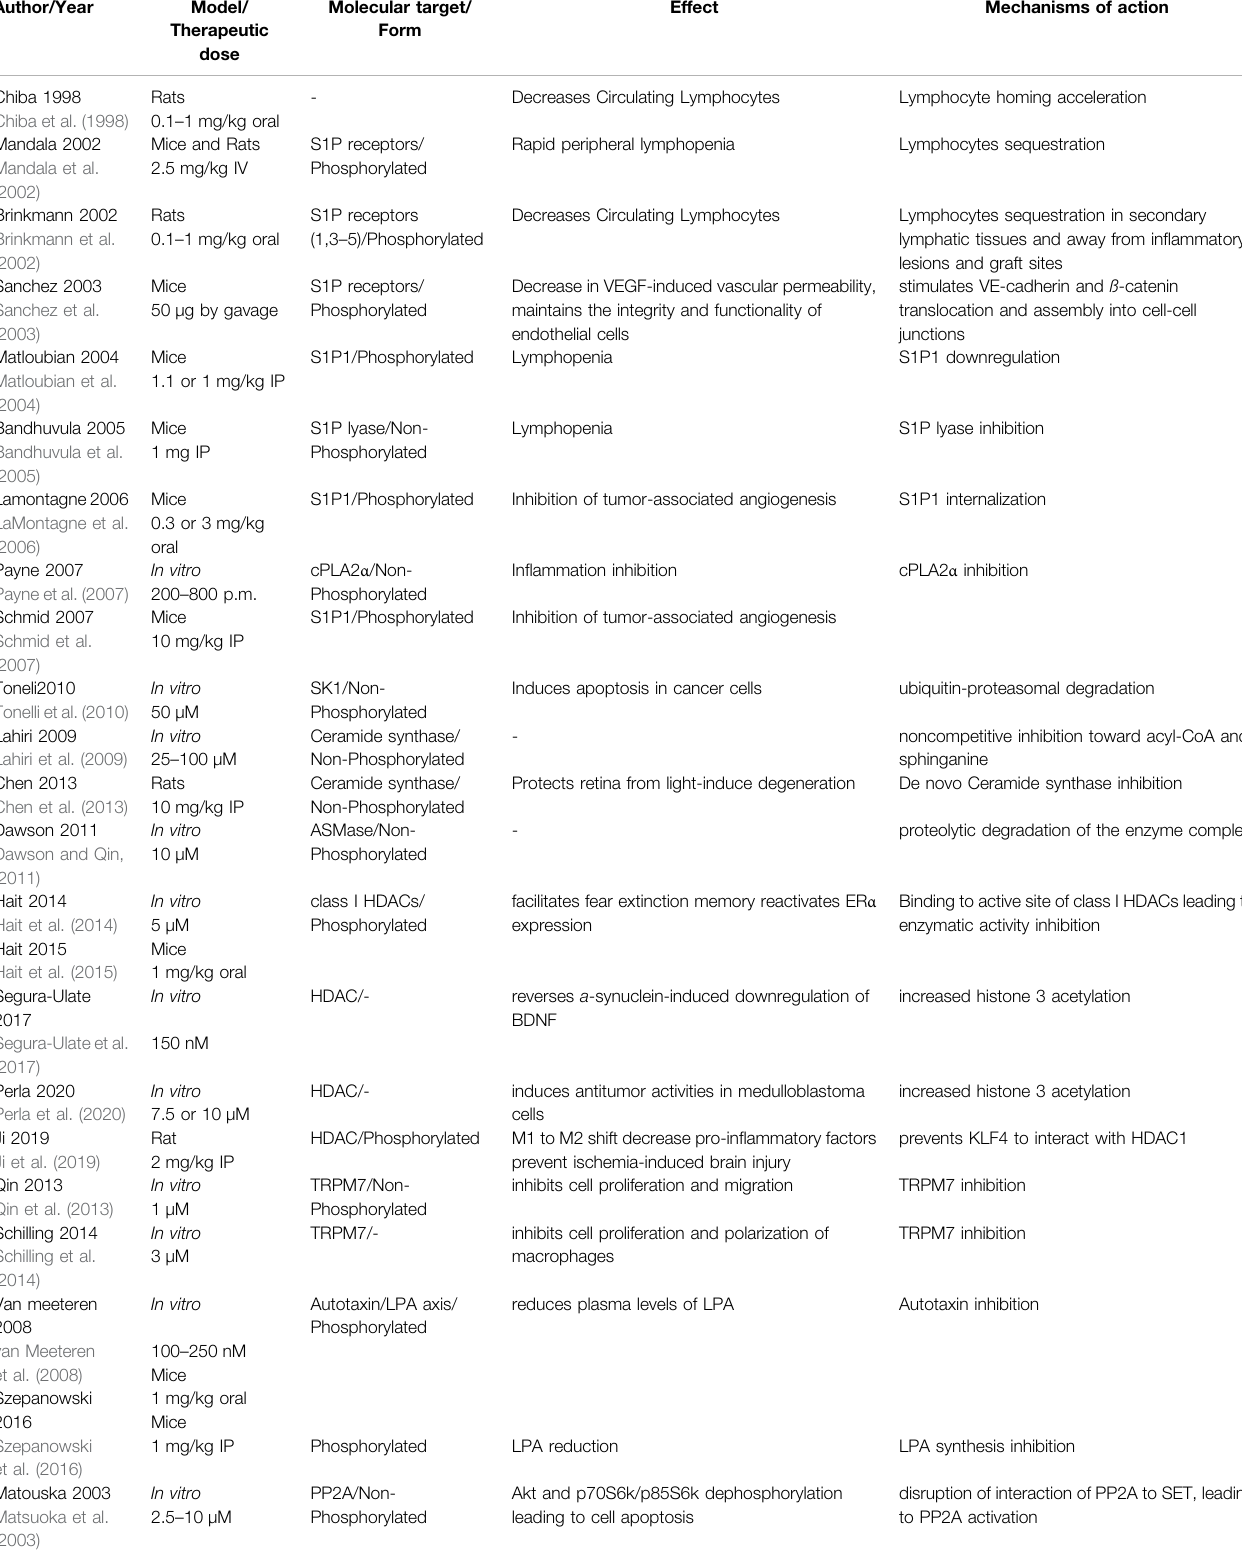
TABLE 2 | Molecular targets of fi ngolimod and its relevant effective